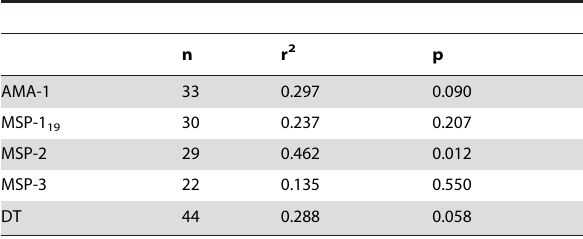
Table 1. Correlation between the two methods of calculating Ag-specific MBC.